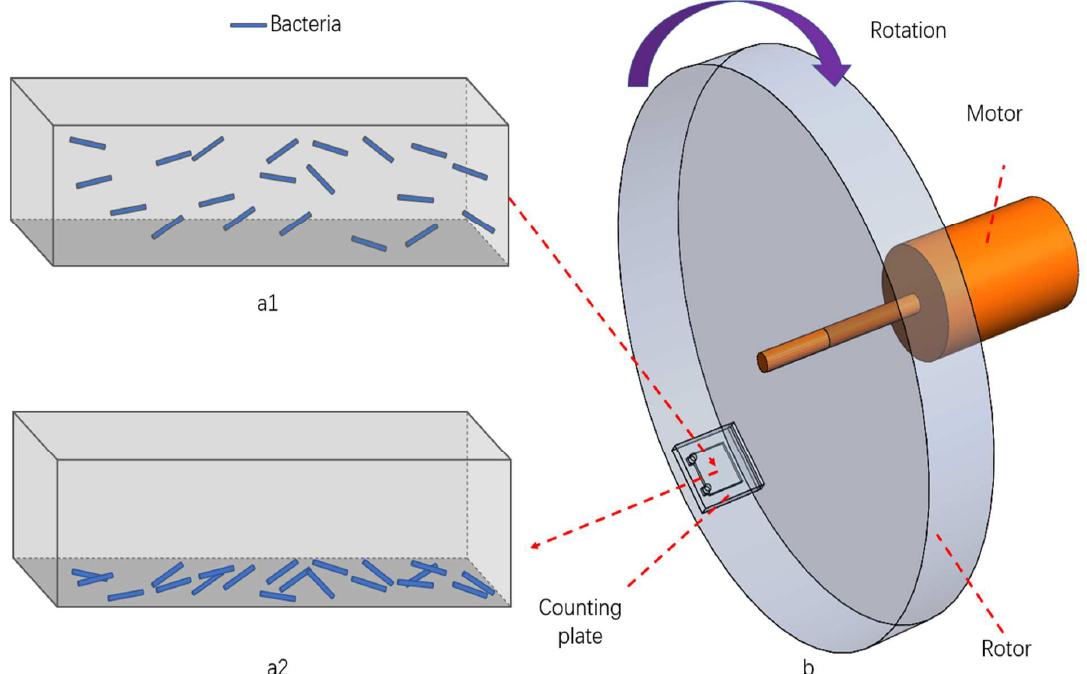
Figure 1. Schematic diagram of centrifugation effect. ( a1 ) Before centrifugation: bacteria floating in the bacteria solution in the inner chamber of the counting plate; ( a2 ) after centrifugation: bacteria settling on the bottom surface of the counting plate; ( b ) centrifuge: the motor drives the rotor to rotate and the counting plate is located at the edge of the